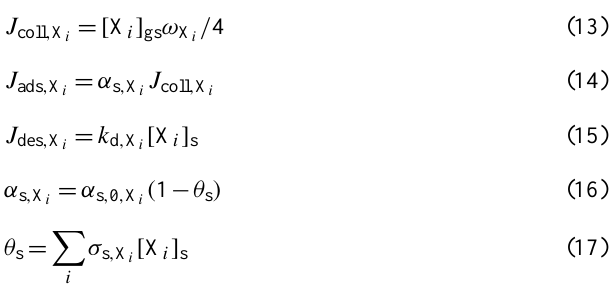
and δ Y are the thicknesses of sorption and i j